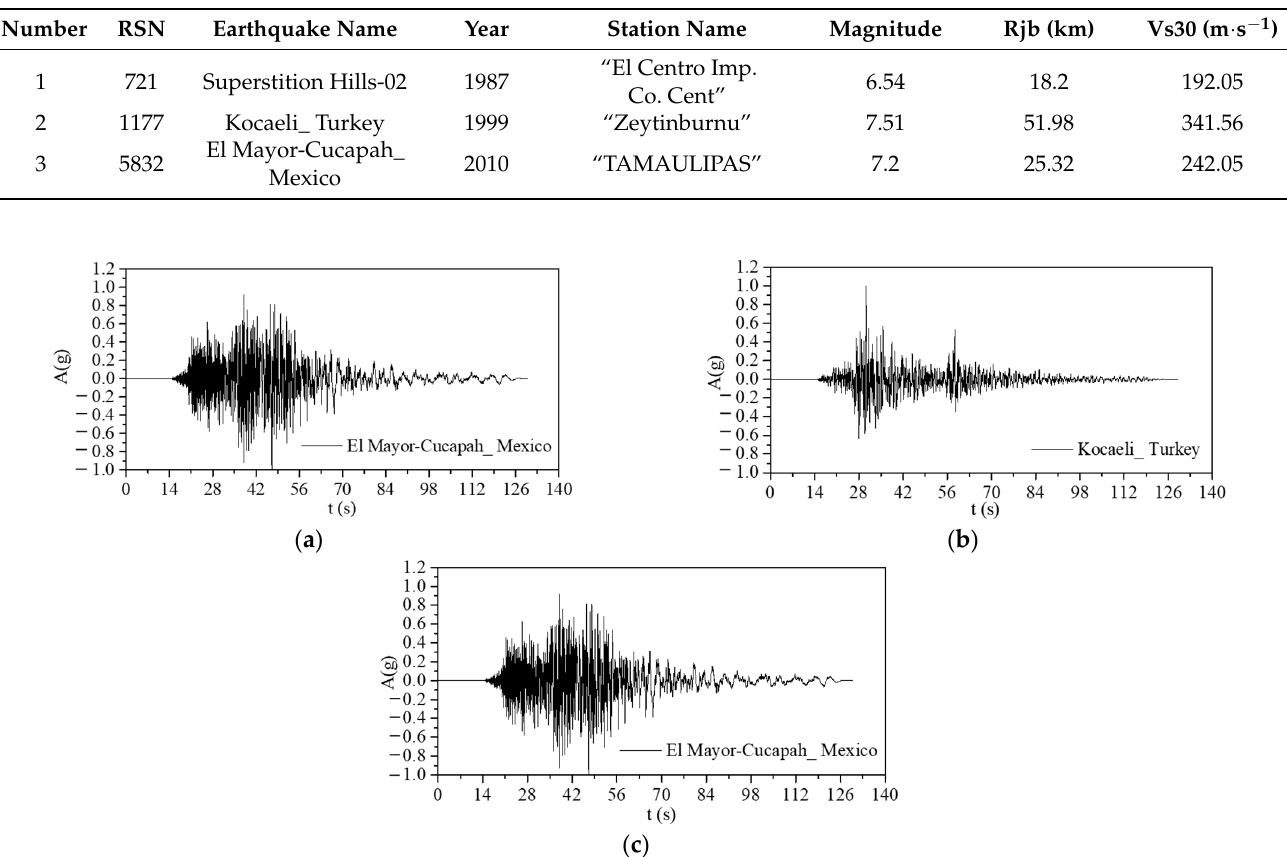
Table 7. Seismic wave recording information.